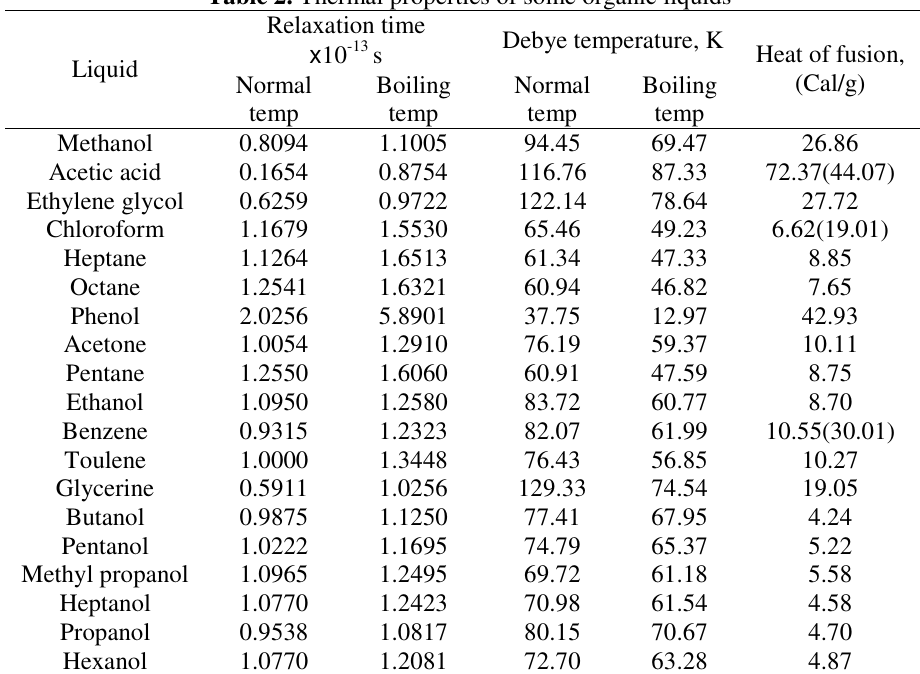
Table 2. Thermal properties of some organic liquids Relaxation time x 10 -13 s Debye temperature,